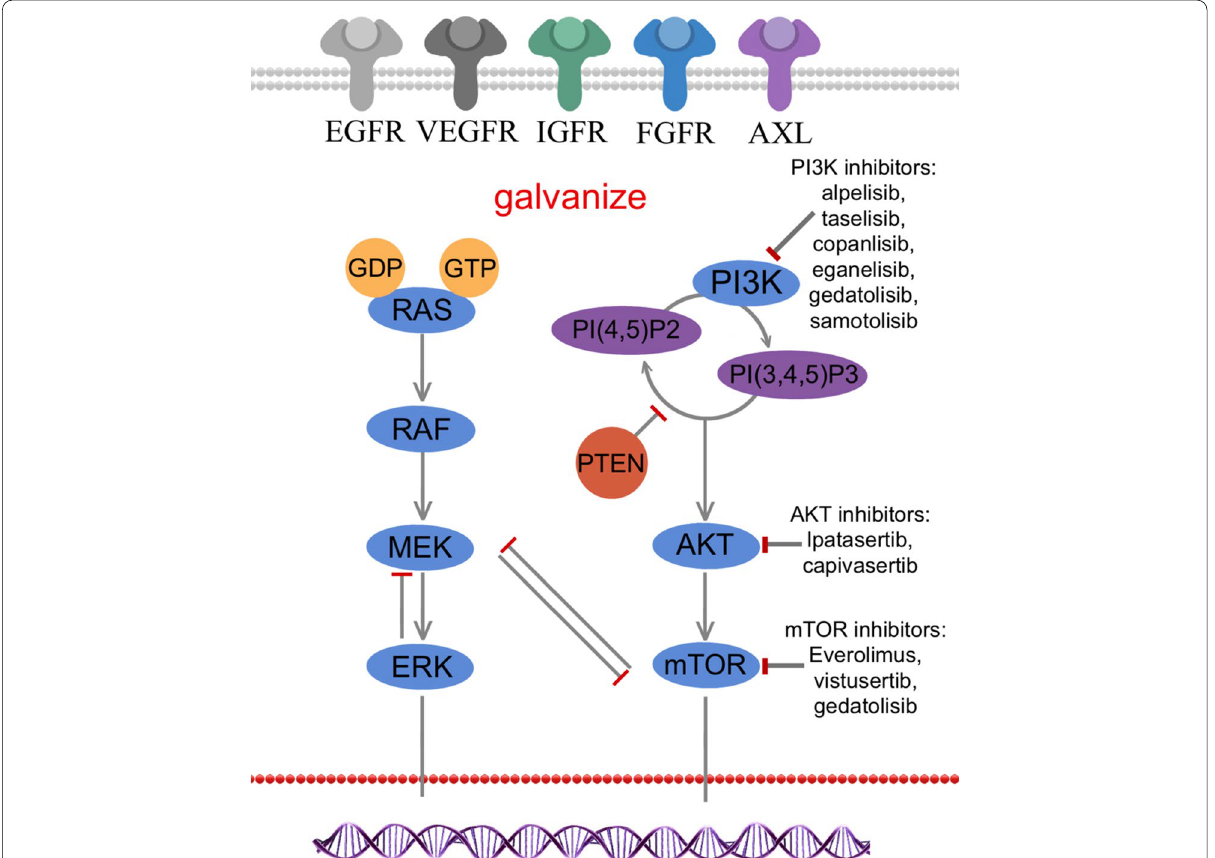
Fig. 1 Receptor tyrosine kinases and associated pathways in TNBC. RTKs bind to extracellular ligands, then activated RTKs then activates downstream PI3K/AKT/ mTOR and Ras/MAPK pathway signaling pathways. After Ras family (N-Ras, M-Ras, H-Ras and K-Ras) is activated, downstream Raf, MEK and ERK in turn transfers the signals released from Ras to the nucleus, and finally drives tumor cell proliferation and survival. PI3K is firstly activated by RTKs, and then phosphorylates PIP2 into PIP3, which binds to AKT, and followed by phosphorylation of threonine. And AKT and mTOR are completely activated in turn. PTEN is a negative regulatory phosphatase of PI3K signaling, which can suppress tumor by converting PIP3 to